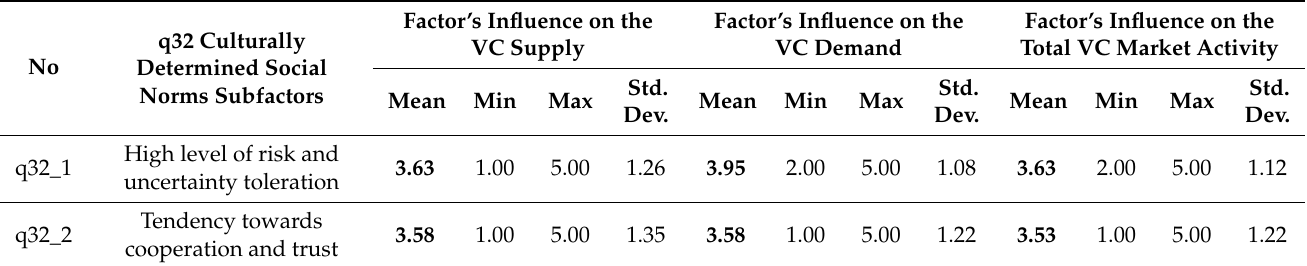
Table 18. The subfactors related to the human resources.